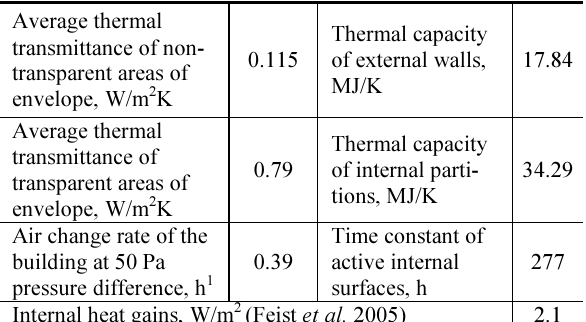
Table 2. Energy properties of the building